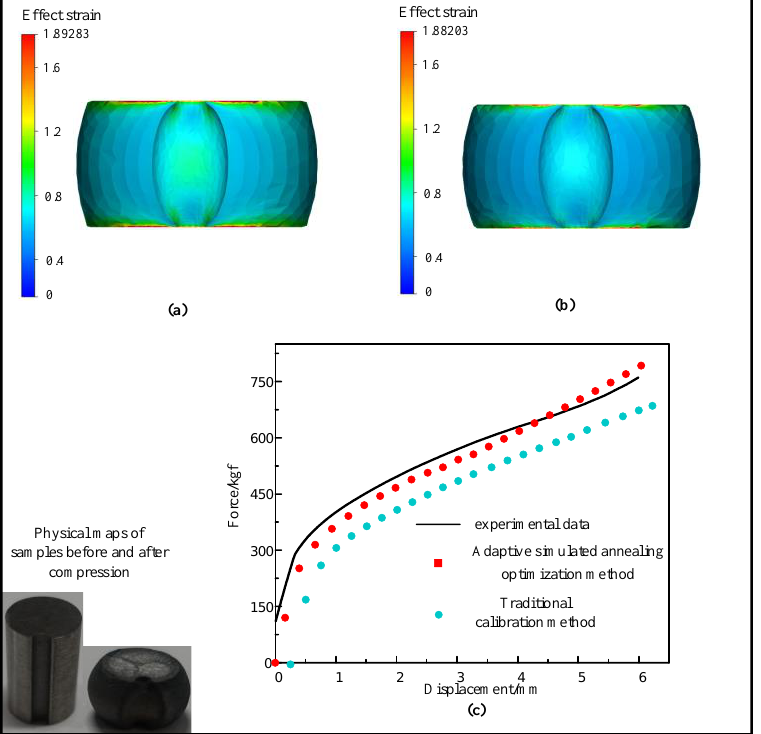
Figure 16. Simulation of cylindrical sample (Ø 8 × 12 mm) with a notch of 1 mm radius: ( a ) the distribution of strain at 1225 °C/0.75 s −1 with adaptive simulated annealing optimization method; ( b ) the distribution of strain at 1225 °C/0.75 s −1 with the traditional calibration method; ( c ) force vs. displacement plot of experimental and predicted values (Hansel–Spittel model of two methods) at 1225 °C/0.75 s −1 .